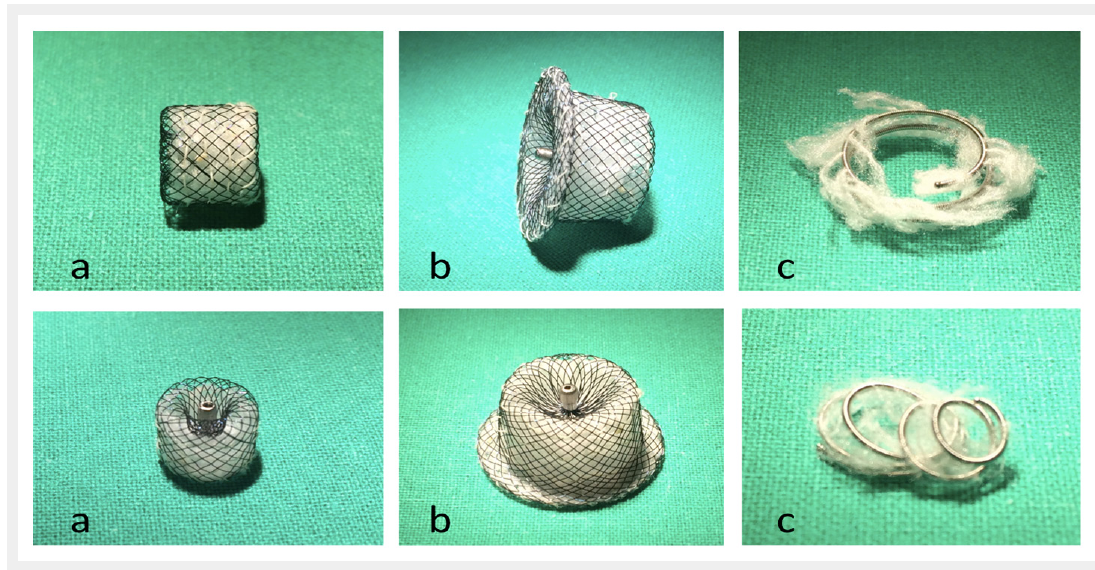
Figure 5 Examples of Hyperion™ vascular plugs (a, b) and a Tornado ® Embolization Coil